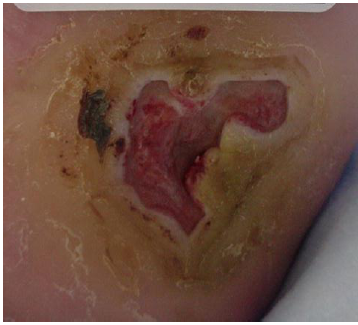
Figure 2. Wound appearance at day 5.